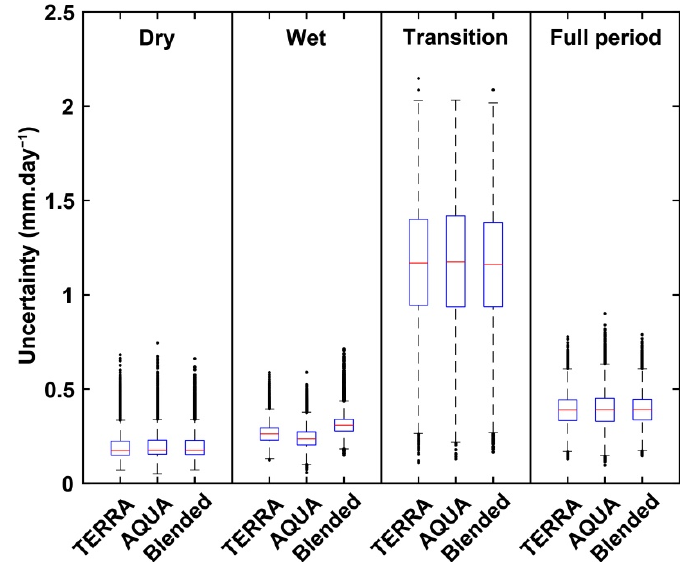
Figure 12. Boxplots of spatial distributions of temporal mean uncertainty on E3S ET d estimates, for each period of the year (top) and each satellite source (bottom).